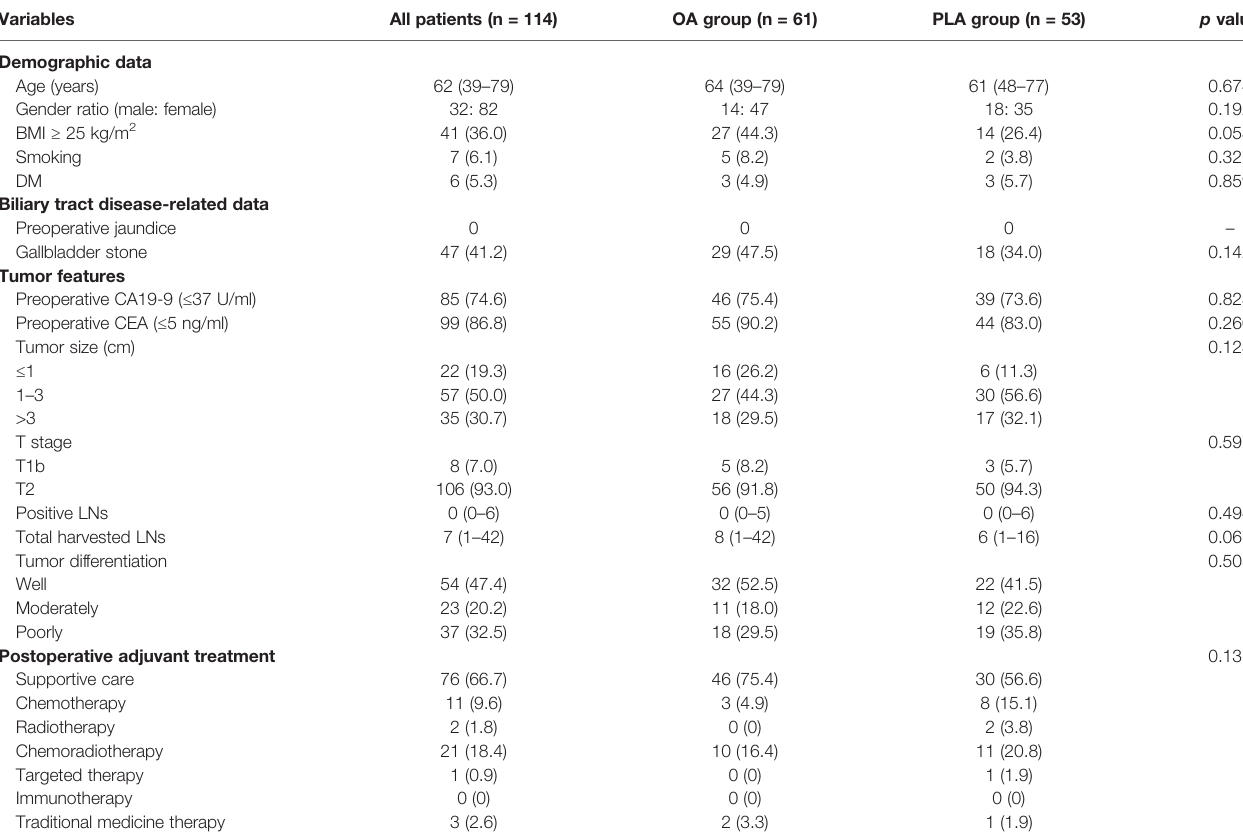
GBC, gallbladder cancer; OA, open approach; PLA, primary laparoscopic approach; BMI, body mass index; DM, diabetes mellitus; CA19-9, carbohydrate antigen 19-9; CEA, carcinoembryonic antigen; LNs, lymph nodes.